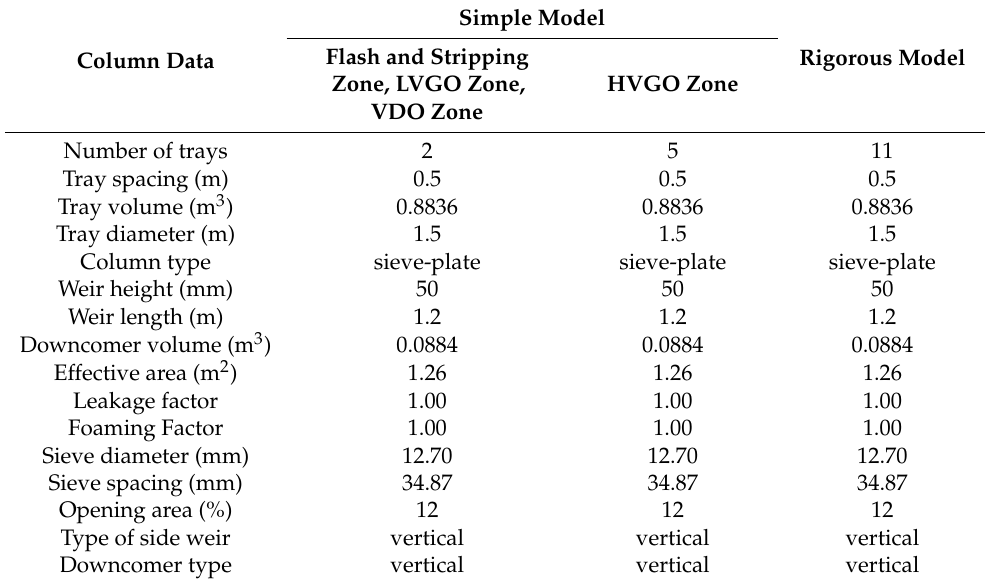
Table 2. Setting data information of each